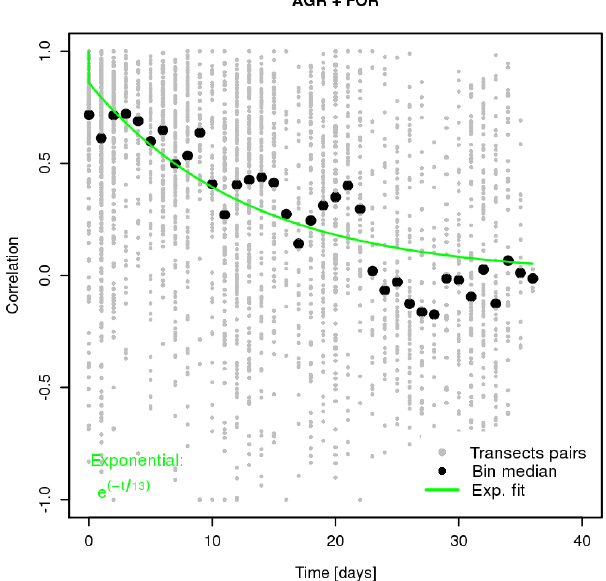
Figure 5. Temporal autocorrelation for VPRM10–aircraft NEE residuals. Black dots represent individual flux transects pairs sam- pled at different times as function of time separation. Black circles represent daily-scale binned